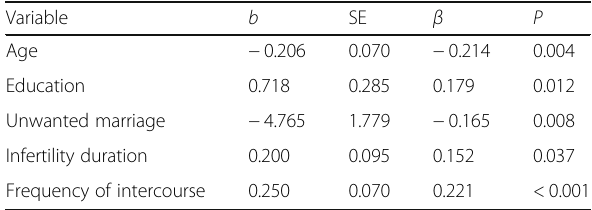
Table 3 Relationship of FSFI-6 scores with demographic and infertility variables in infertile women using stepwise